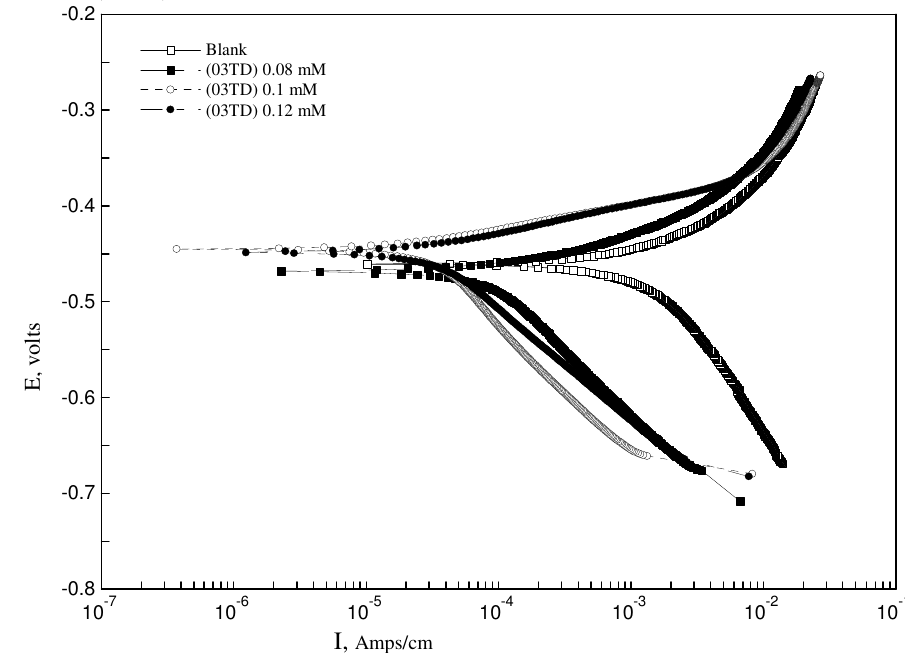
Figure 3. Potentiodyanamic Polarization curves for mild steel in 1 M H presence of (02TD).